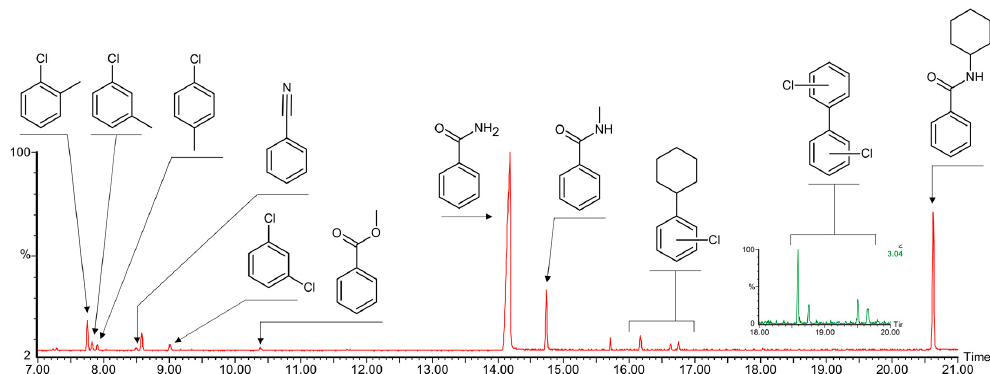
Figure 14. Fragment of the chromatogram showing the reaction products and by-products of the amidation of cyclohexane with benzamide catalysed by 1 . The initial parts of the chromatogram containing peaks of the solvent, substrate, and internal standard are omitted for clarity.